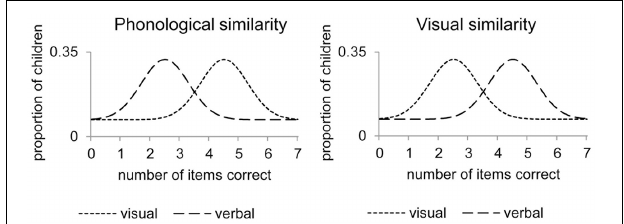
FIGURE 2 | Expected distribution of children (cid:2) s responses when verbal (dashed) or visual (dotted) STM processes are used. Legend: The responses of all the children are represented by a mixture of distributions reflecting the latent states. One distribution represents the responses of children using verbal STM processes (dashed lines). These children have lower means on the phonologically similar tasks than on the visually similar tasks. The other distribution represents the responses of children using visual STM processes (dotted lines), who have a lower number of items correct on the visually similar tasks than on the phonologically similar